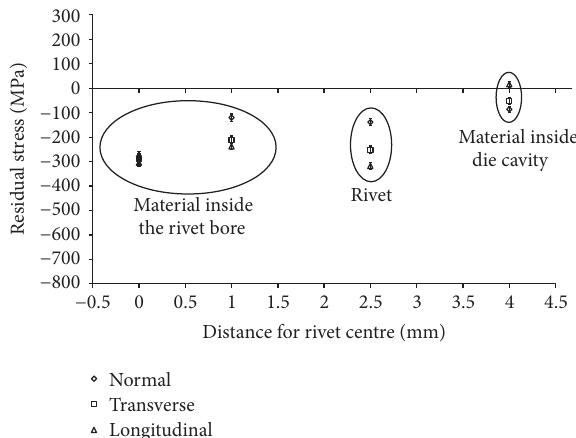
Figure13:Distributionofresidualstressintherivetlegandadjacent sheet material in joint II along HH line as depicted in Figure 5(a).